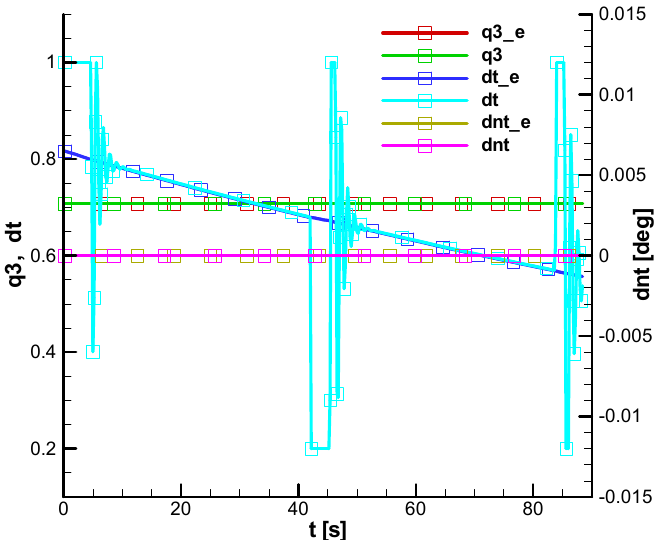
Figure 8. The equilibrium commands and q3 component for evolution in the first scenario.